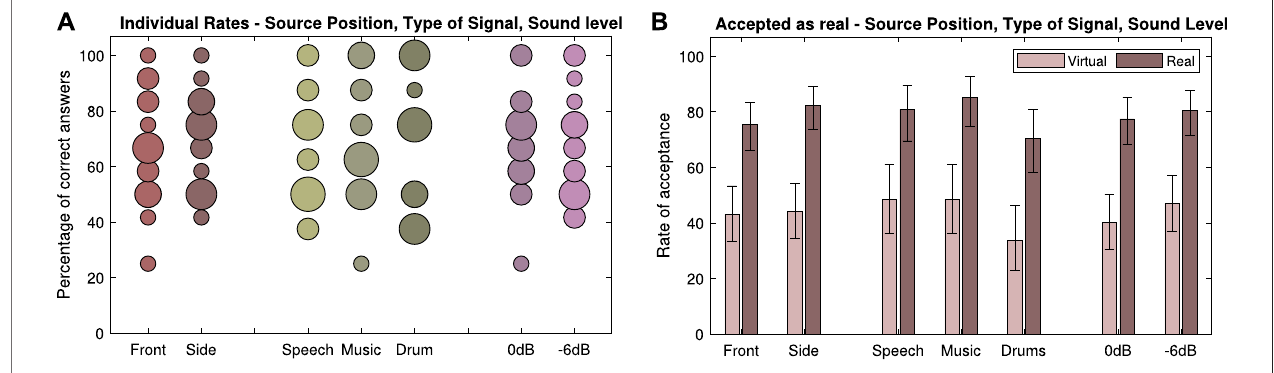
FIGURE 7 | (A) The individual rates of correct assignments were not signi fi cantly in fl uenced by the position of the sound source, the type of source signal or the sound level - (B) No signi fi cant in fl uence of source position, type of signal and sound level on the acceptance of the real and the virtual sound source in Part II could be observed in this